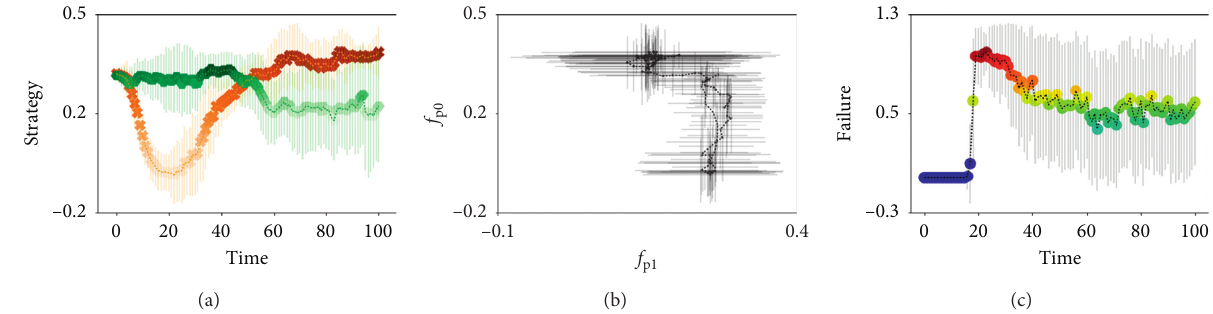
Figure 5: Described protection dynamics against systemic risk with small exploration rate. The plot of the left-hand side shows a trend of the � red, f � green, dashed vertical lines � variability), corresponding to its evolutionary trajectory (middle side of the plot: two strategies ( f p0 p1 dot � averaged value, strength of the dot � time step, dashed horizontal and vertical lines � variability). Note that the plot of the right-hand side represents the failure (vertical axis) and variability (dashed vertical line) at each time step (horizontal axis). Initialized parameters of the simulations are nodes n � 100, connection p � 0.9, capital c � 1, f � 1, c � 0.5, p � 0.001, p � 0.1, and t � 100. p p , max p , 1/2 n l